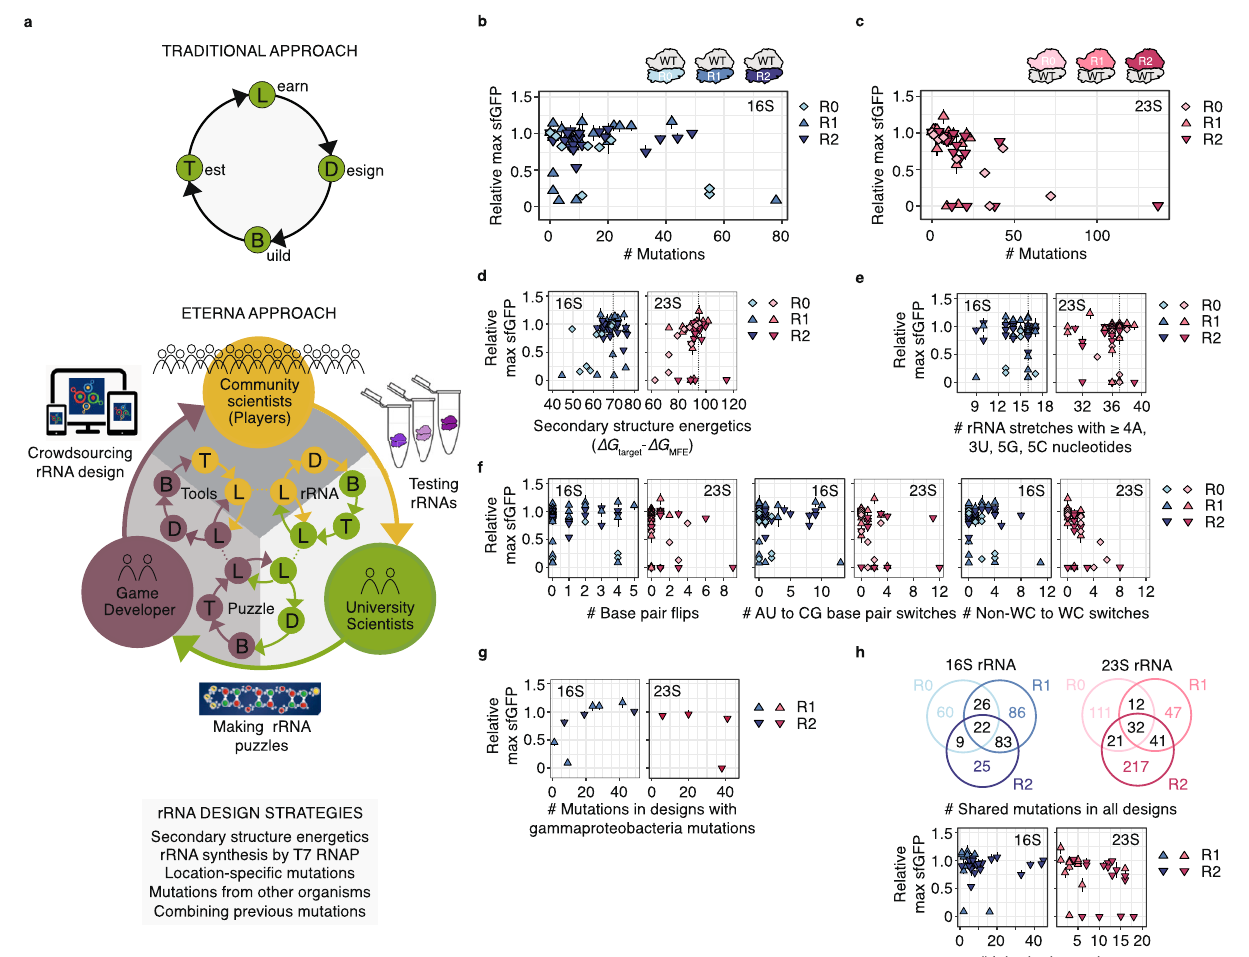
Fig. 2 | The Eterna approach transforms traditional design-build-test-learn cycles. a Our Eterna approach integrates the strengths of community scientists, university scientists, and game developers, who solve RNA design challenges by closelyworkingtogether.Weperformedtworoundsofourapproach.Functionality comparison of Round 1 (R1) and Round 2 (R2) Eterna 16S rRNA b and 23S rRNA c designs in iSAT with the “ pilot round ” (R0) in dependence of the designs ’ muta- tion counts. To approach the OpenRibosome Challenge, community scientists followed and combined different strategies: d secondary structure energetics,